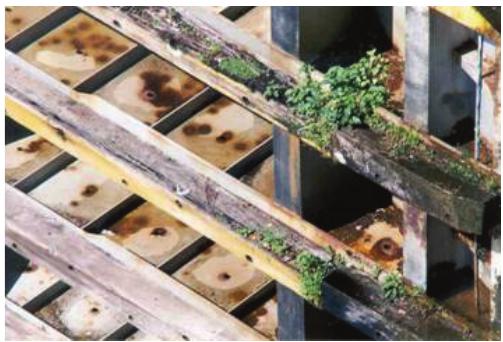
Figure 1: Corrosion on a miter gate.